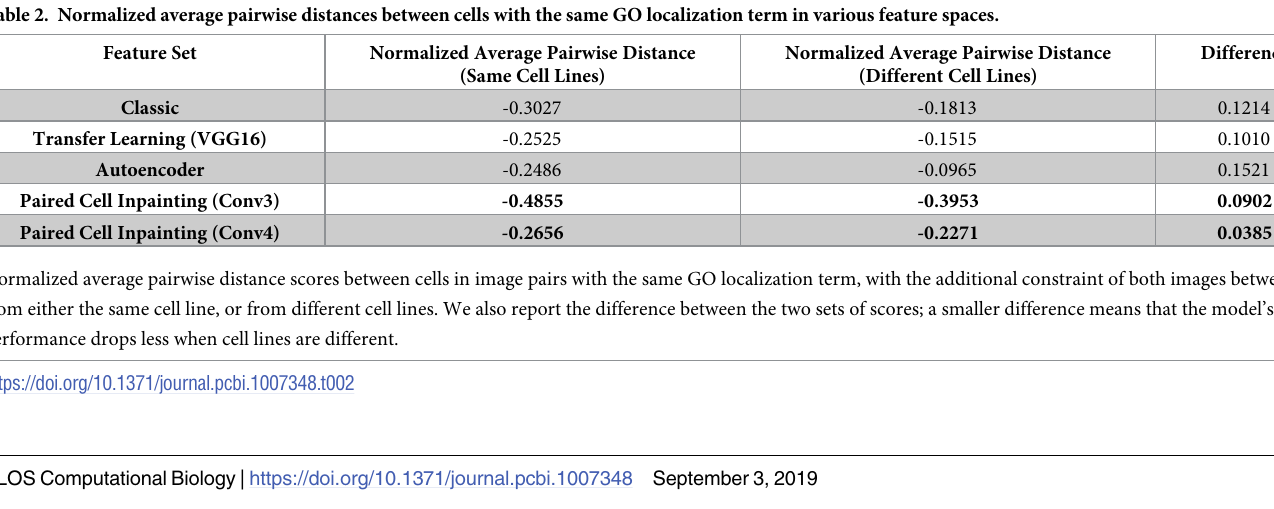
Table 2. Normalized average pairwise distances between cells with the same GO localization term in various feature spaces. Feature Set Normalized Average Pairwise Distance